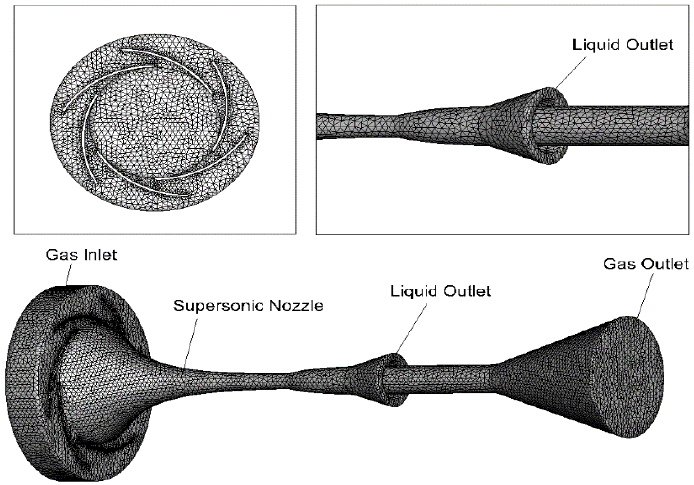
Figure 4. Three-dimensional grid of supersonic separator.